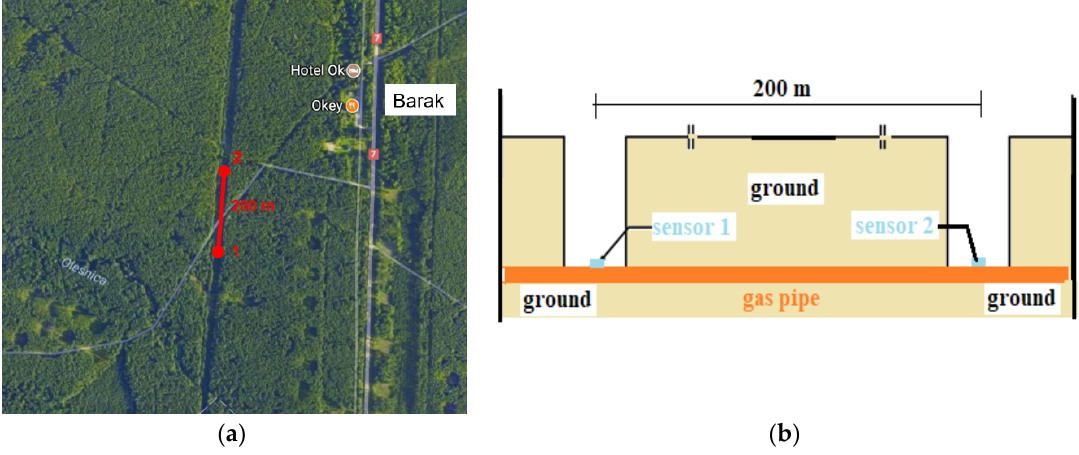
Figure 5. ( a ) Arrangement of measuring points on the gas pipeline. ( b ) Measuring scheme.